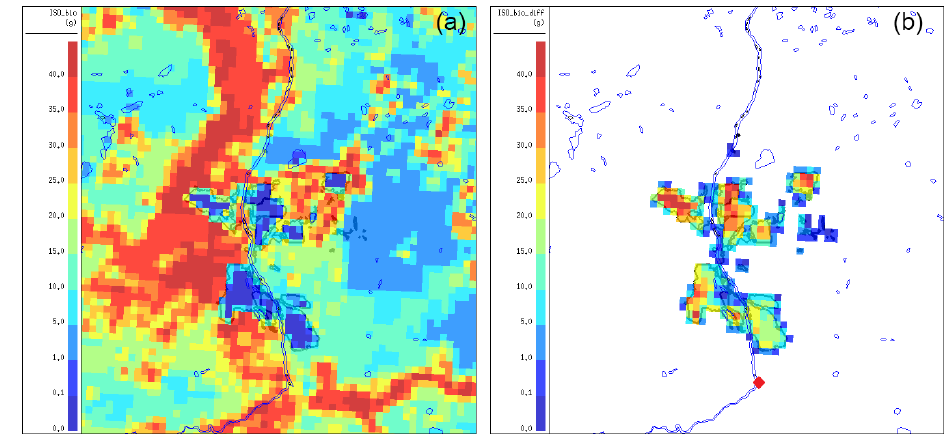
Figure 7. (a) Modified biogenic isoprene emissions for a portion of the 2.5km OS grid centered on the AOSR study area and (b) difference between the original and the modified isoprene emissions (original – modified). The gray lines indicate the cleared-land areas within the boundaries of the OS mining facilities. The location of Fort McMurray is indicated by the diamond